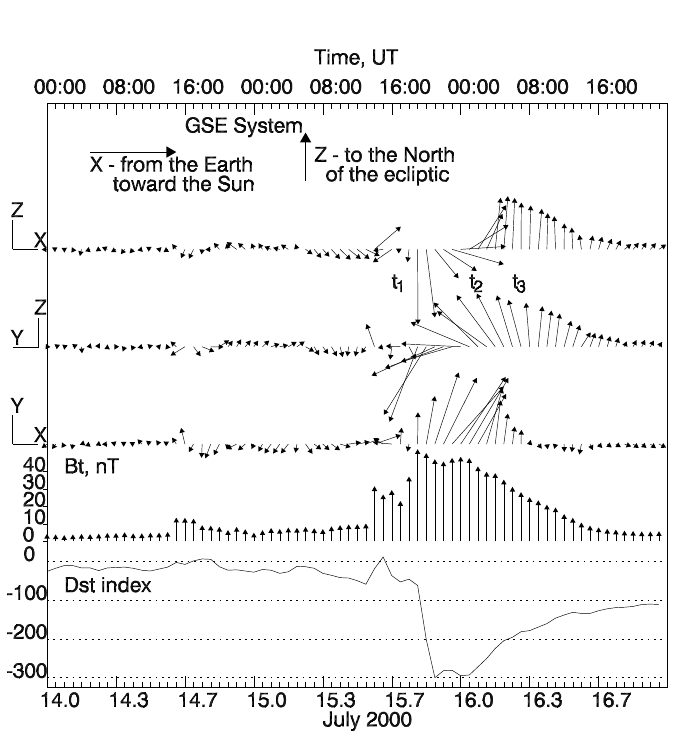
Fig. 7. Yohkoh and TRACE pre- and post-flare images of the 14 July 2000 two-ribbon flare. Bottom: HSOS lon- gitudinal field overlaid with a linear force-free field lines. North – to the top, west – to the right.